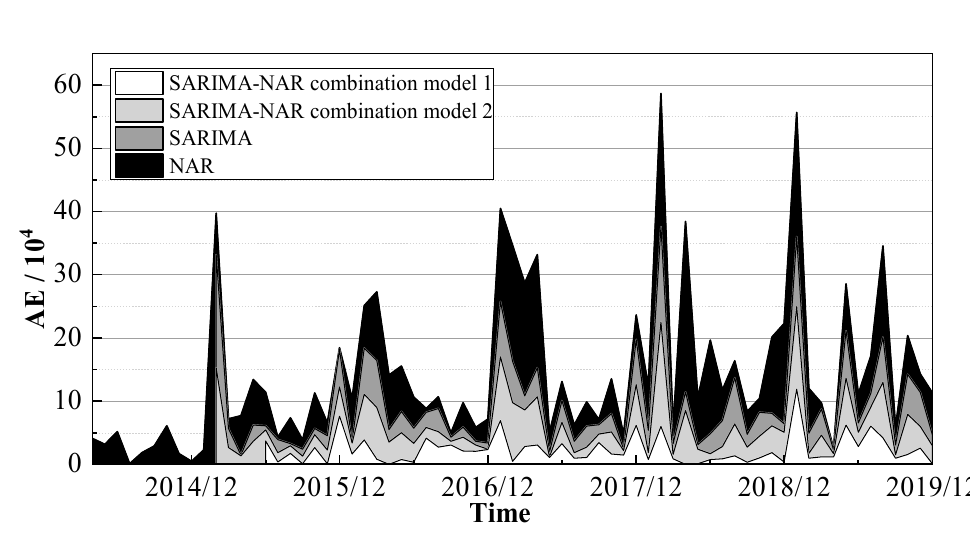
Figure 9. Absolute error area chart.